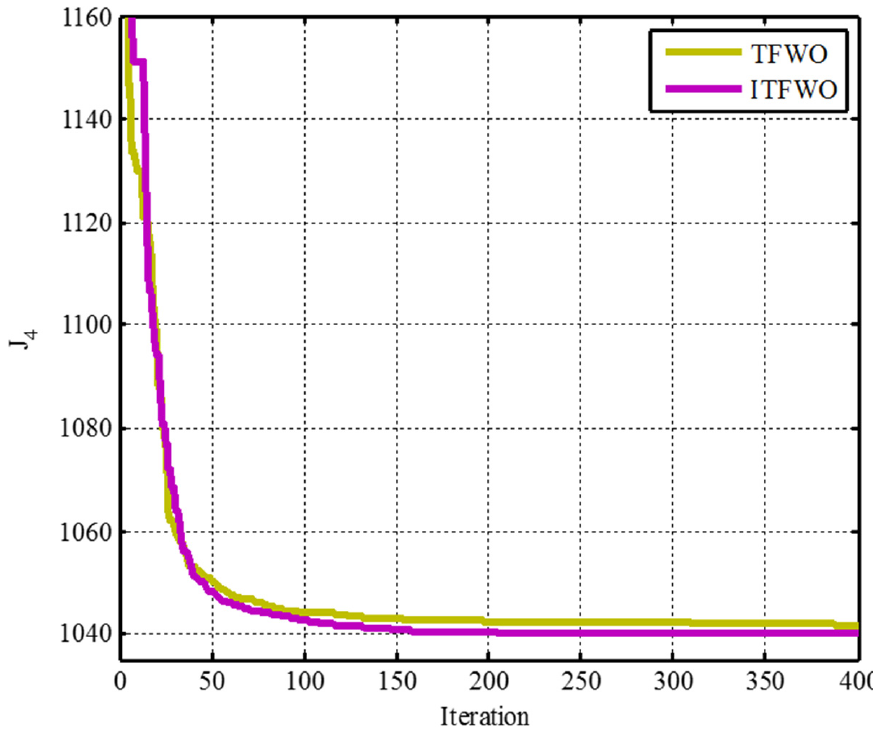
Figure 4. Optimization process for Type 2. Table 3. The optimization results for Type